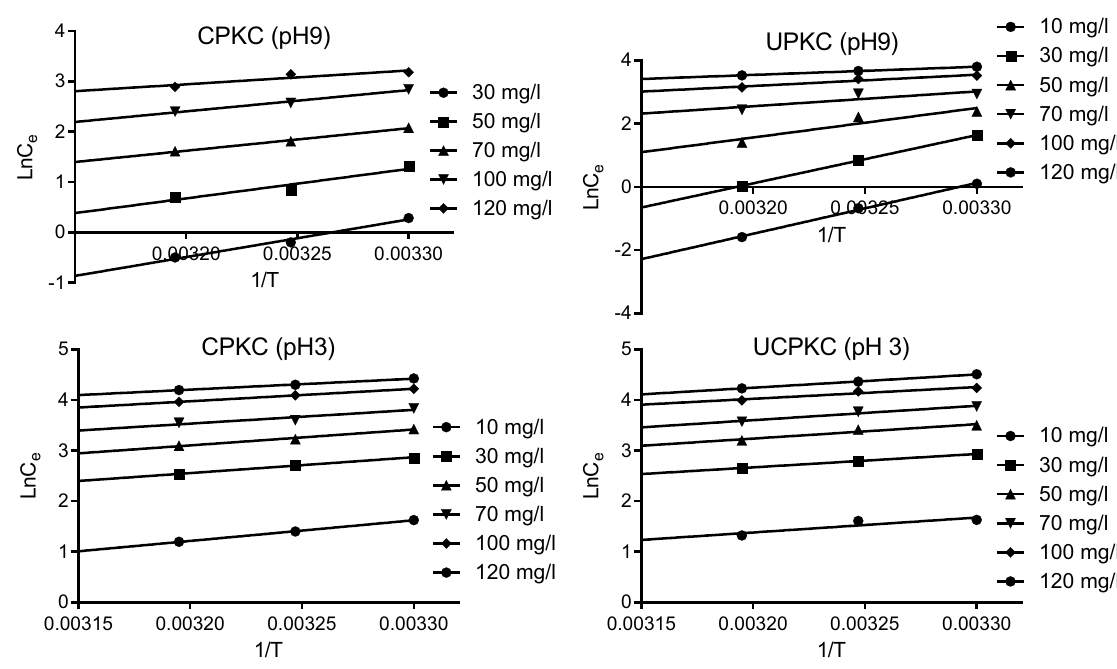
Figure 8. Plots of LnC e versus 1/T for determination of isosteric heat of